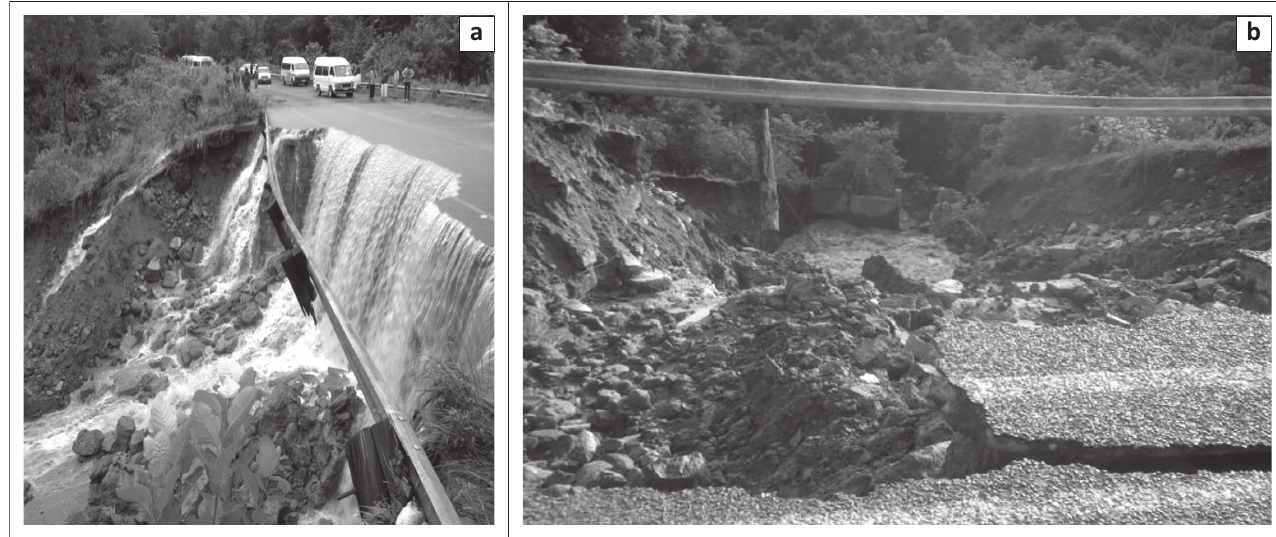
FIGURE 4: Total collapse of Nzhelele to Sibasa bridge (18–21